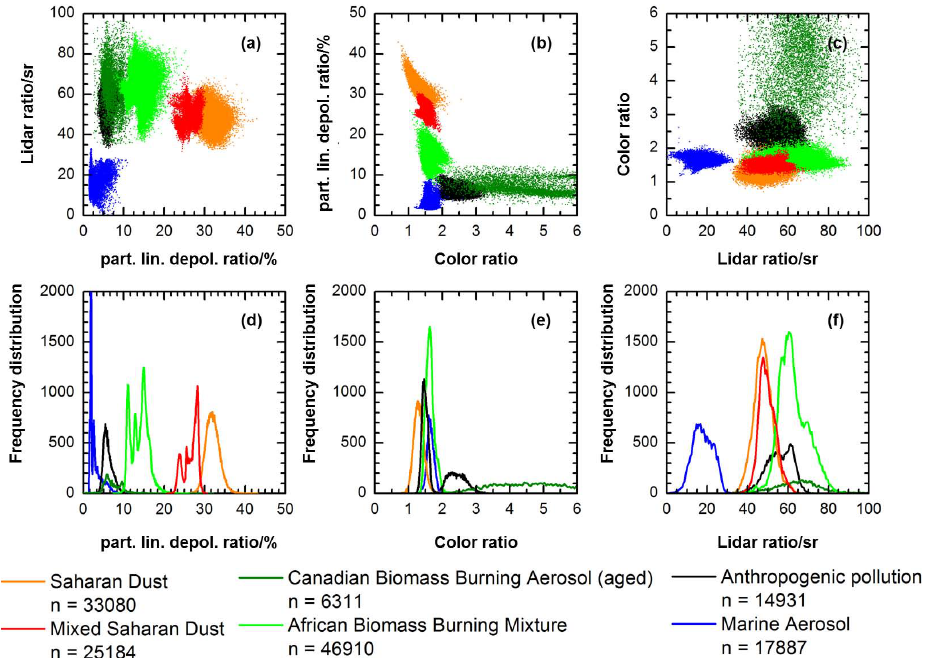
Fig. 5. Characteristic lidar quantities of various atmospheric aerosol types (a) – (c) with frequency distribution (d) – (f) , as well as the total number of measurement points (n) for each aerosol type. Each point in (d) – (f) represents a single lidar